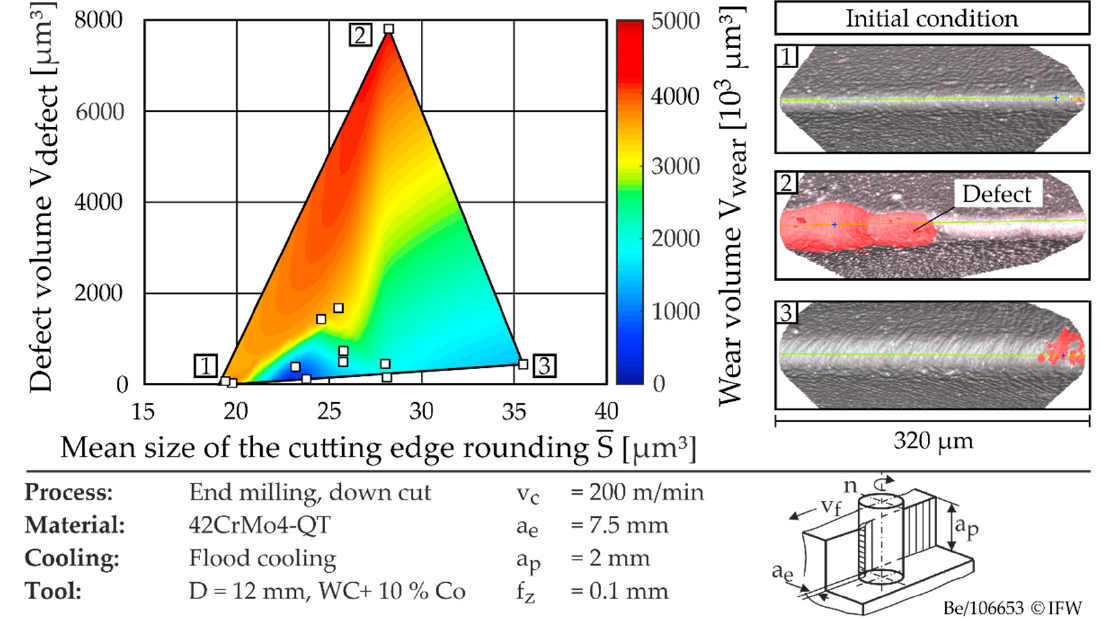
Figure 14. Wear volume as a function of defect volume and cutting edge rounding.